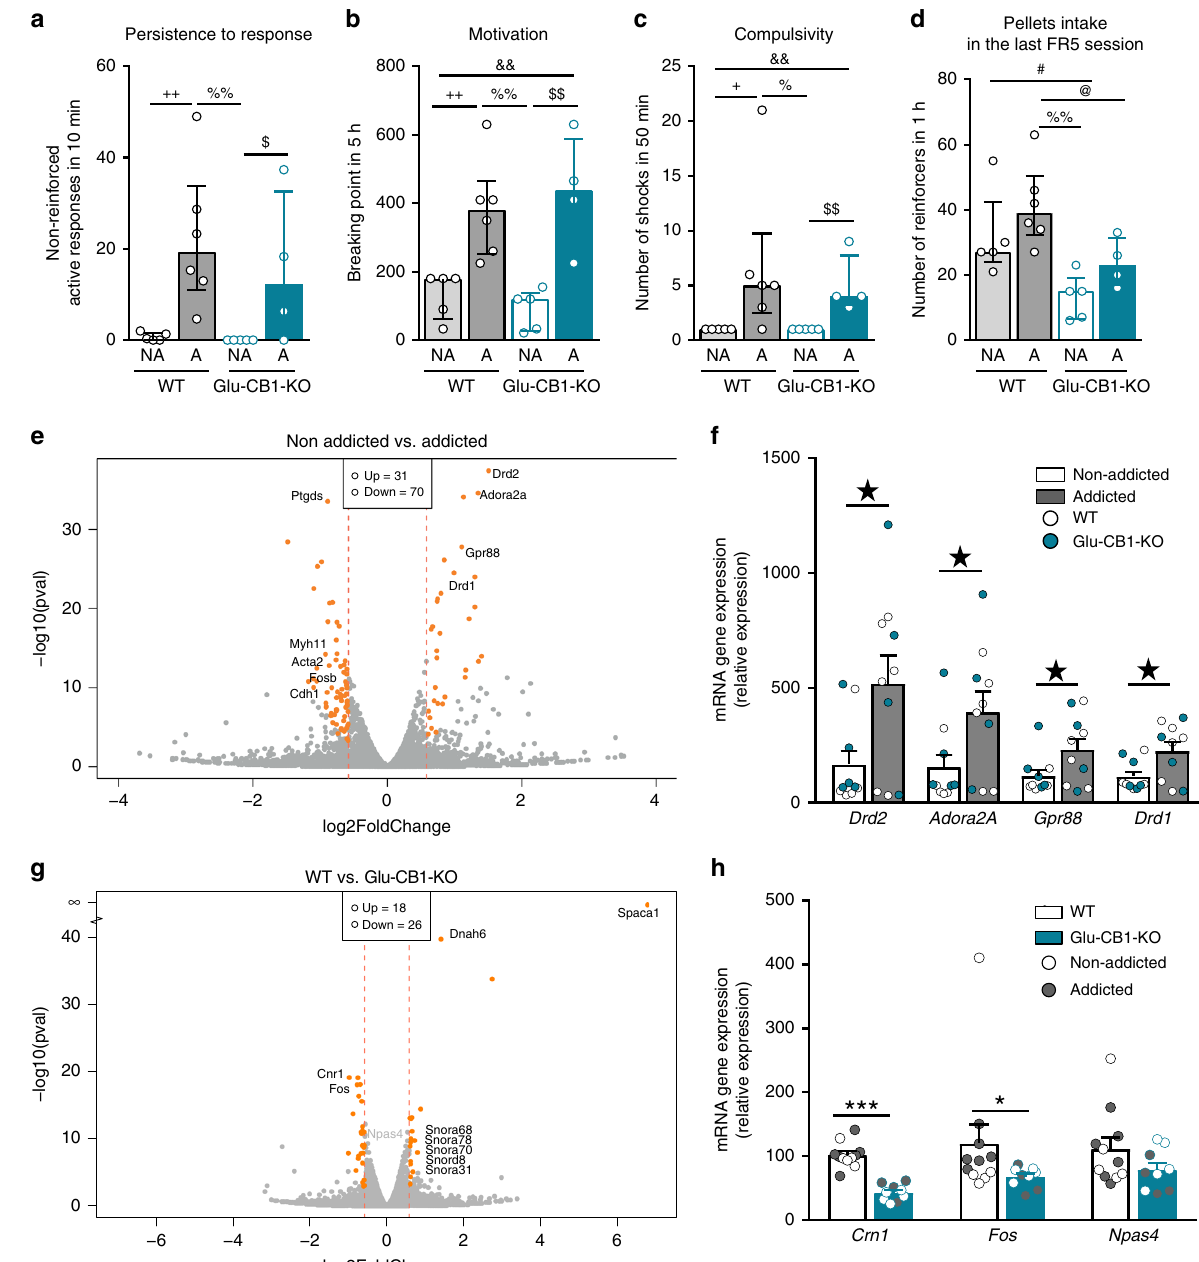
Fig. 4 Drd2 gene expression is upregulated in mPFC of addicted mice. a – c Behavioral tests of the three addiction-like criteria during the late period for those mice selected for RNA-seq in each of the four groups, addicted (A) and non-addicted (NA) mice in both genotypes (individual values and bars with median and the interquartile range; n = 5 WT NA, n = 6 WT A, n = 5 Glu-CB1-KO NA, n = 4 Glu-CB1-KO A). a Persistence to response. b Motivation. c Compulsivity. d Pellets intake in the last FR5 session before sample collection. e , g Volcano plot of the RNA-seq data analysis. The cutoff of 1.5-fold change and differentially expressed genes are highlighted in orange. e Differentially expressed genes in addicted mice compared to non-addicted mice. g Differentially expressed genes in Glu-CB1-KO compared to WT mice. f , h Quantitative real-time PCR of selected genes. ( + P < 0.05, + + P < 0.01 WT NA vs. WT A, # P < 0.05 WT NA vs. Glu-CB1-KO NA, && P < 0.01 WT NA vs. Glu-CB1-KO A, % P < 0.05, %% P < 0.01 WT A vs. Glu-CB1-KO NA, @ P <